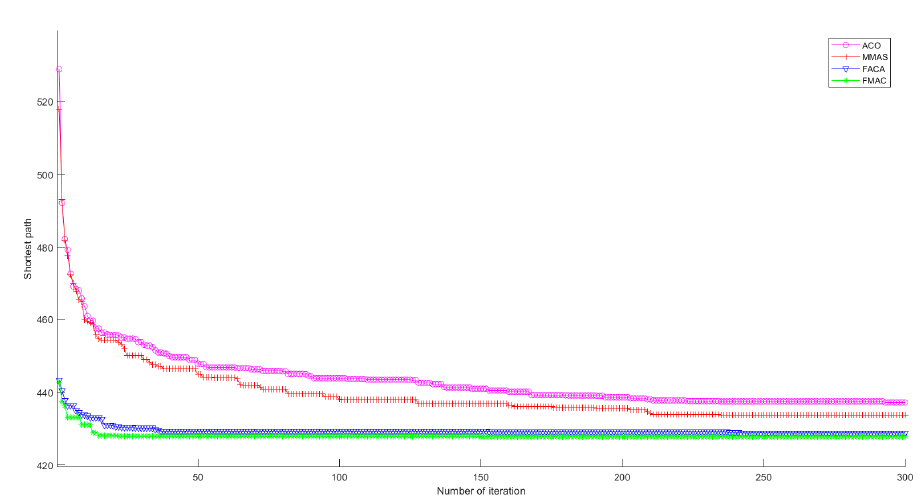
Figure 8. Average shortest path curve after each iteration in eil51.